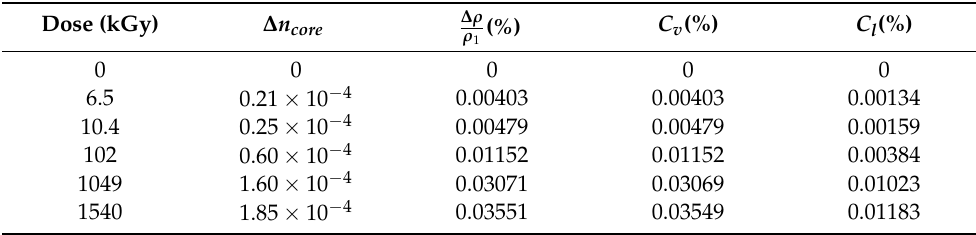
Table 2. Calculated values of density and length compaction (based on the RI values) using Equa- tions (3)–(5).